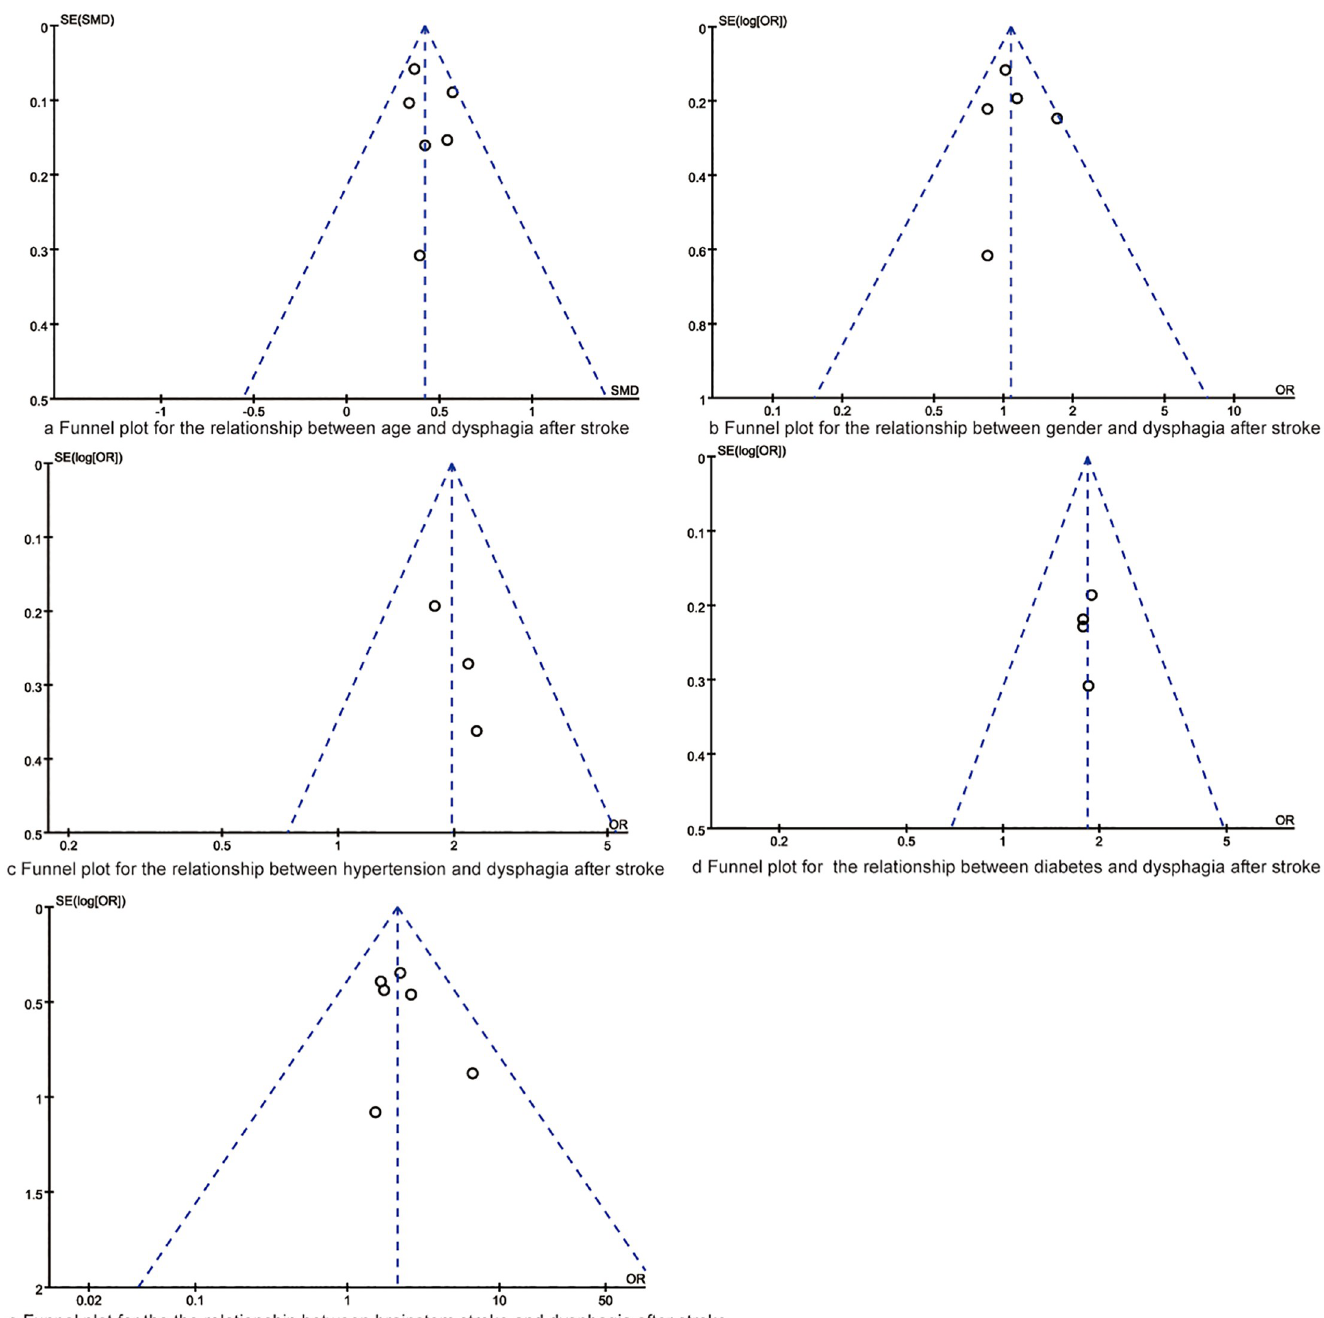
Fig 7. Funnel plots for the synthesized